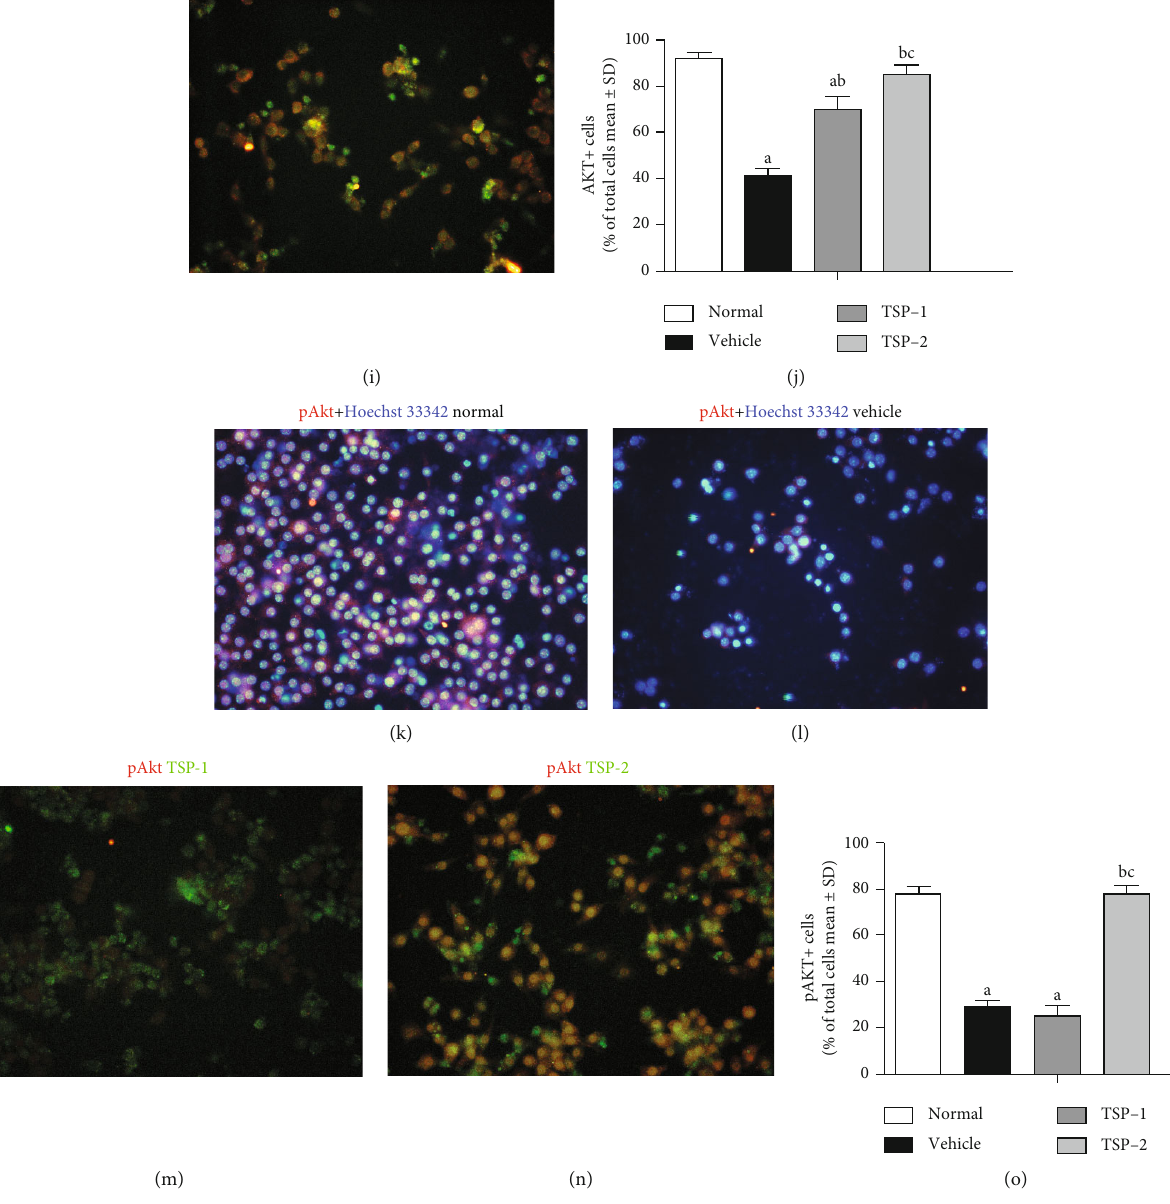
Figure 3: Impact of TSP-2 overexpression on PI3K signaling in vitro . MH-S murine alveolar macrophage cells were either untreated (normal and nontreatment) or treated with LPS (1 μ g/ml) for 24h following either empty vector (vehicle group), TSP-1 (TSP-1 group), or TSP-2 (TSP-2 group) overexpression. MH-S cells were stained with p85 (a – d), total Akt (f – i), and p-Akt (k – n) antibodies to assess the impact on PI3K signaling. Red color is antibody-speci fi c staining, blue color is Hoechst 33342 nuclei staining, and green color is GFP-labeled TSP-1- and TSP-2-overexpressing cells. Yellow color shows colocalization of TSP-1 or TSP-2 with speci fi c proteins. (e, j, and o) Bar graphs showing parallel comparisons of antibody staining quantitation among the four groups. The percentage of labeled cells/total cell numbers is shown as mean ± SD . P value of < 0.05 represents signi fi cant di ff erence. a P < 0 : 05 compared with normal control; b P < 0 : 05 compared with the vehicle group; c P < 0 : 05 compared with the TSP-1 transfected group ( n = 5 per